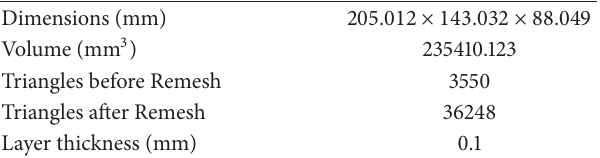
Table 2: The HEO model